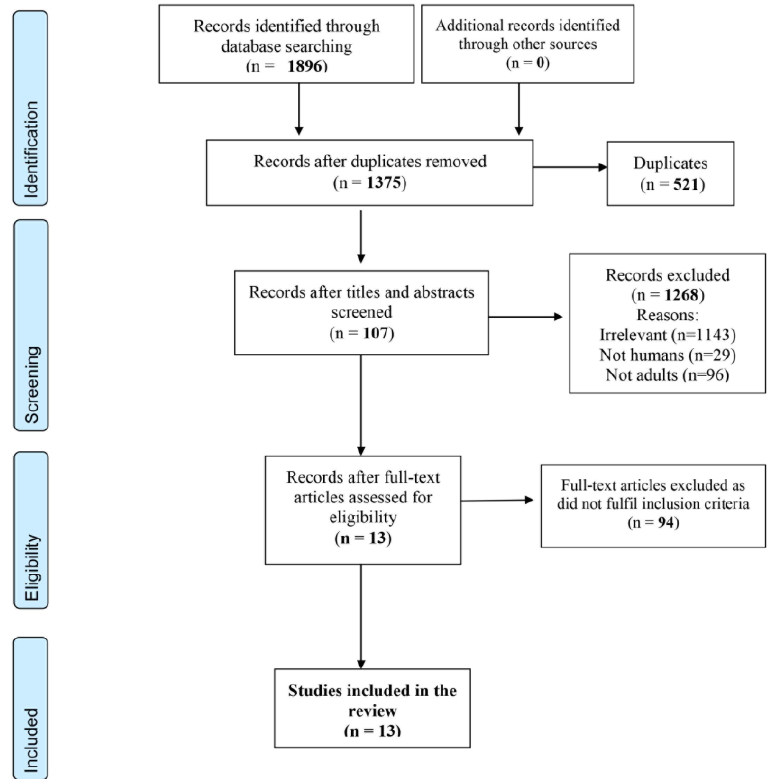
Figure 1. PRISMA 2009 Flow Diagram.